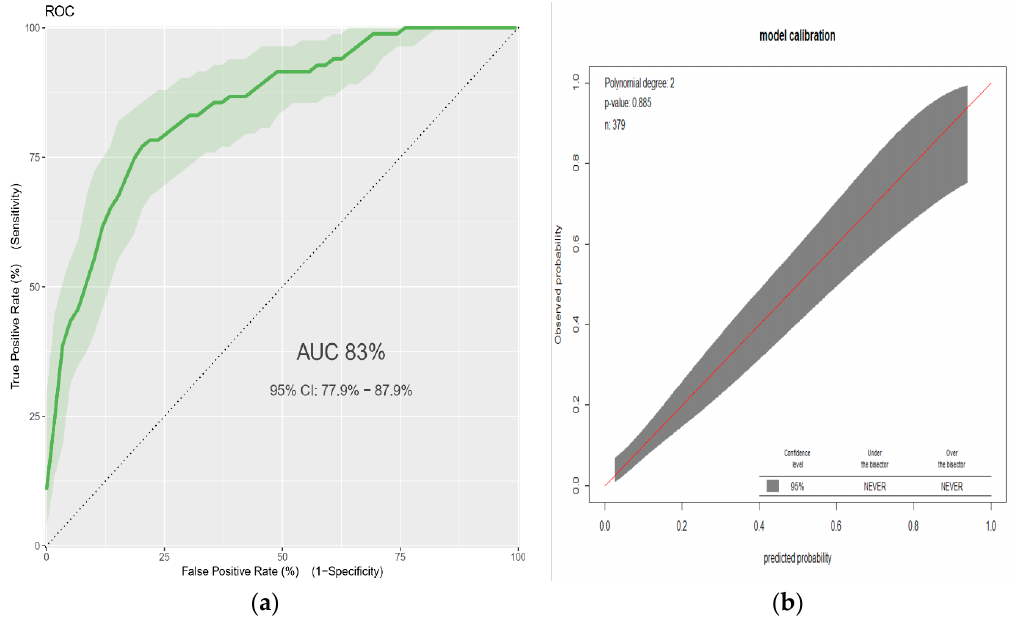
Figure 1. ( a ) Area under the ROC curve for the prediction model, and ( b ) predicted versus observed low birthweight probability in the sample. This analysis includes neonates born at term (n = 379). The calibration plot created using “ givitiCalibrationBelt ” in R programming. Linear predictors for estimated risk of low birthweight = 1 / (1 + exp − ( − 2.54 + 1.593 × age( < 20) + 1.516 × BMI ( < 18.5) + 1.213 × hemoglobin ( < 11) + 1.225 * height ( < 155) + 0.606 × prim-gravid + 1.475 × comorbidity. ROC = receiver operating characteristic.